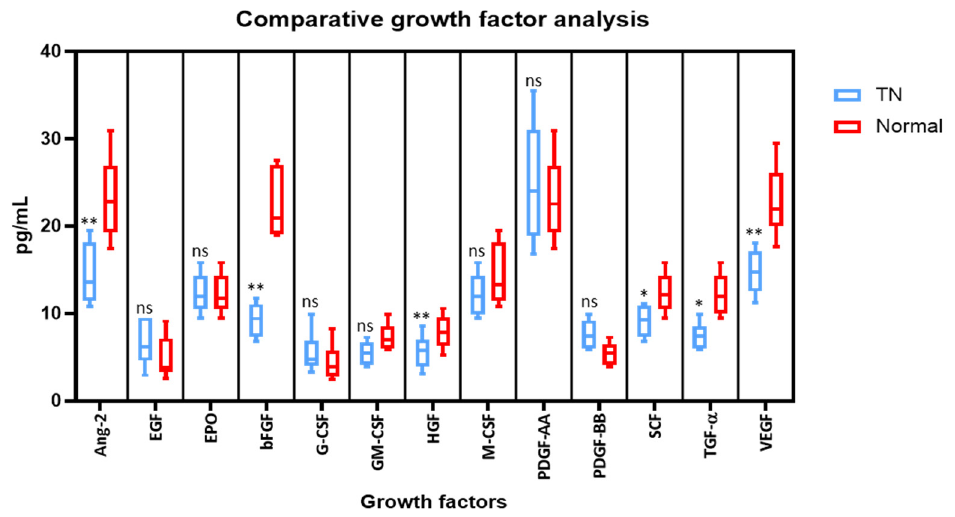
Figure 2. Comparative analysis of growth factors in the saliva of subjects with and without trigeminal neuralgia by cytometric bead array on a flow cytometer. * p < 0.05, ** p < 0.01. VEGF: Vascular endothelial growth factor, TGF- α : Transforming growth factor-alpha, SCF: Stem cell factor, PDGF-AA: Platelet-derived growth factor AA, PDGF-BB: Platelet-derived growth factor-BB, HGF: Hepatocyte growth factor, bFGF: Basic fibroblast growth factor, EPO: Erythropoietin, EGF: Epidermal growth factor, Ang-2: Angiopoietin-2, G-CSF: Granulocyte colony-stimulating factor, GM-CSF: